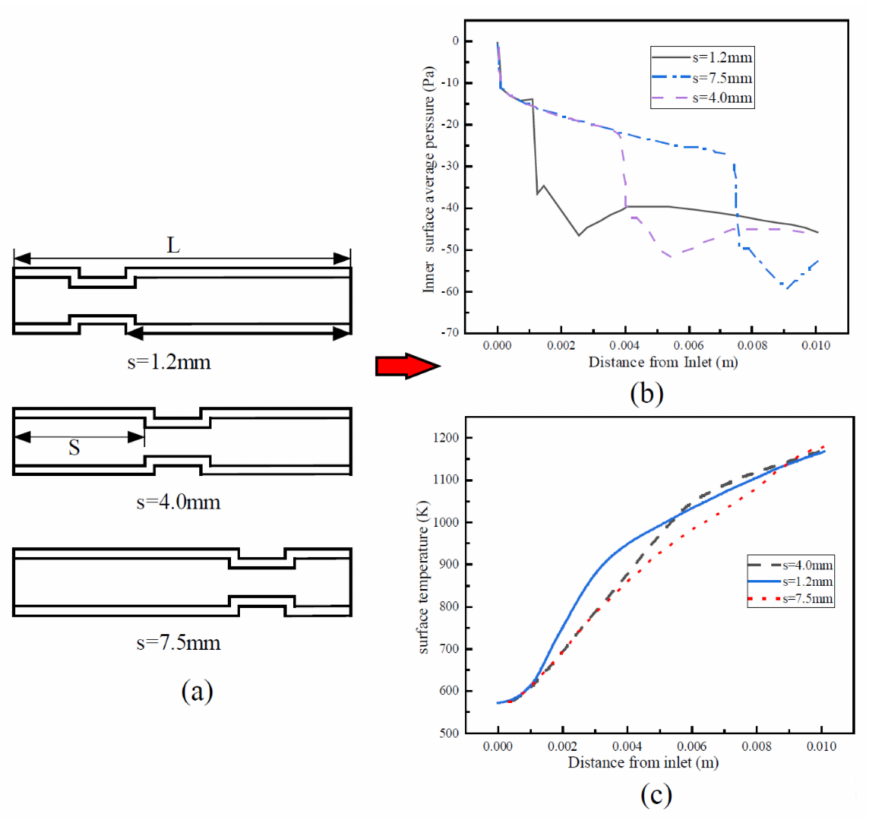
Figure 15. Profile of CH 4 mass fraction, ( a ) Combustor structure, ( b ) The inner-surface average pressure, ( c ) The surface temperature.